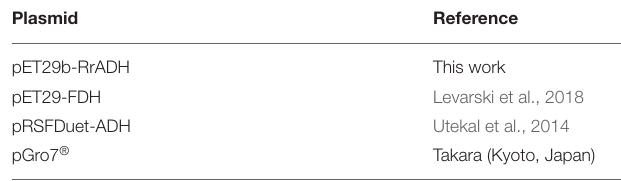
TABLE 2 | Plasmids used in this